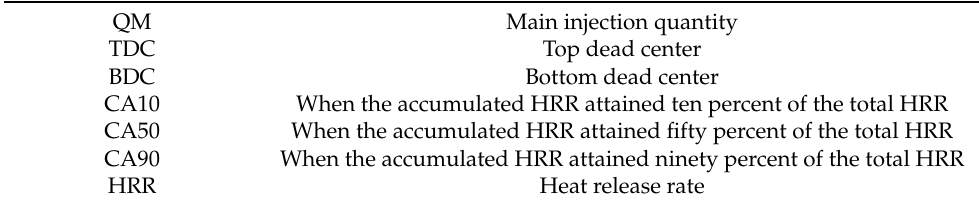
Table A1. The abbreviations used in this